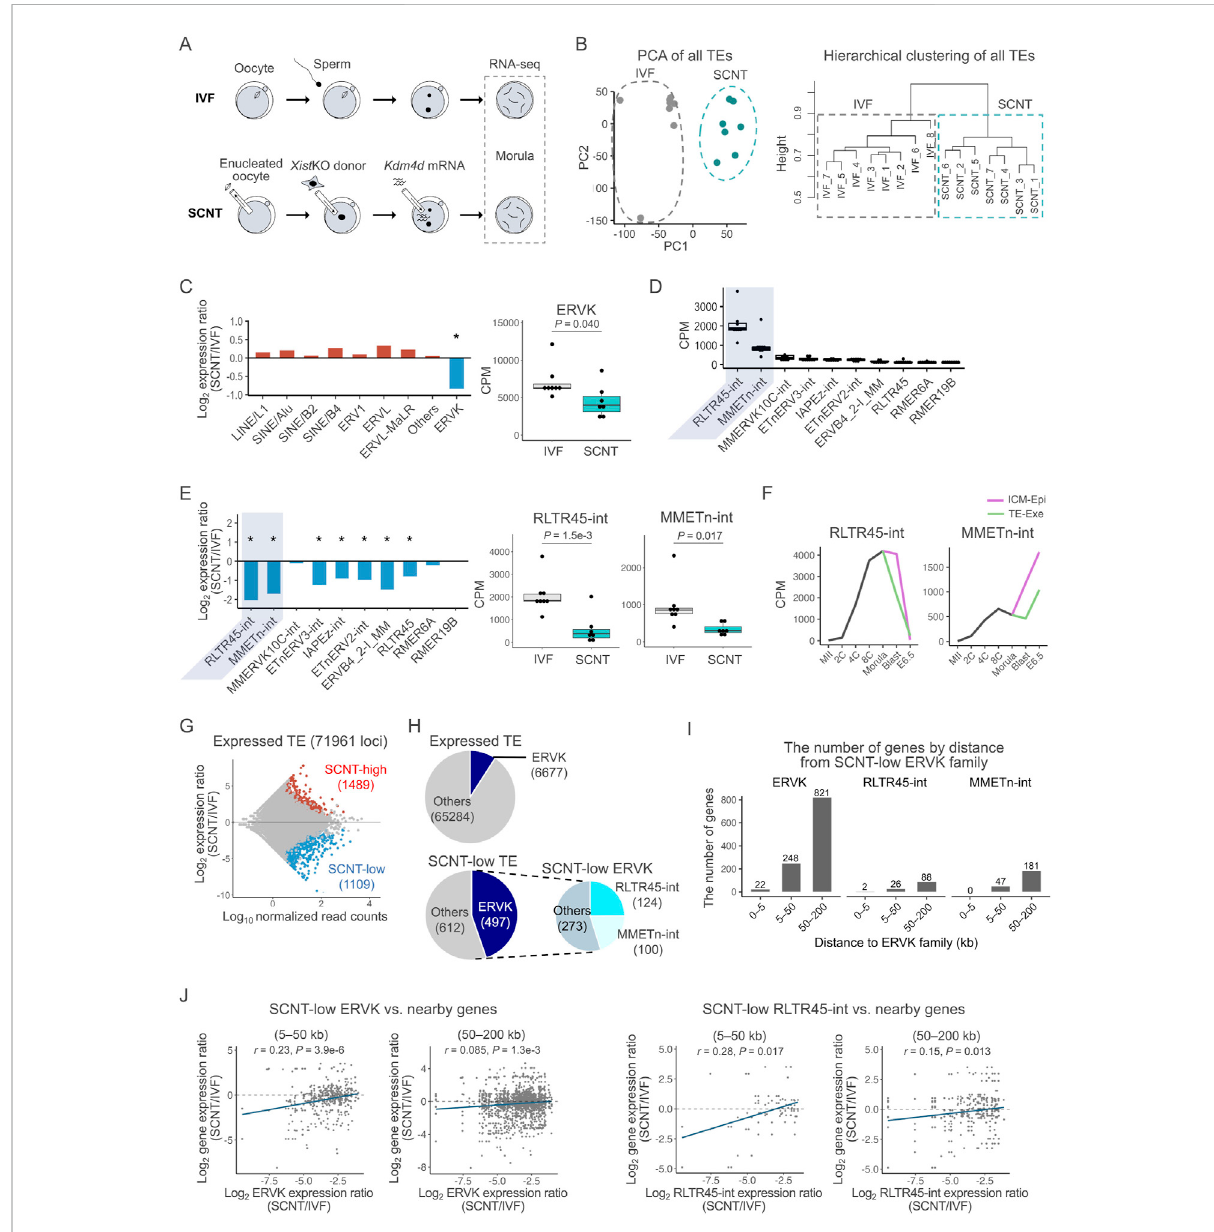
FIGURE 1 Expression of ERVK was suppressed in SCNT-derived embryos. (A) Schematics of the experimental design. Embryos at the morula stage were used for single-embryo RNA-seq analysis (B) PCA of the genome-wide TE expressions in IVF and SCNT-derived embryos. Grey and blue dots representIVF-andSCNT-derivedembryos,respectively(left).Hierarchicalclusteringanalysisofthegenome-wideTEexpressionsinIVF-andSCNT- derived embryos (right). (C) Bar graph showing the log 2 expression ratio of each TE family in IVF and SCNT-derived embryos (left). Box-and- whisker plots comparing the expression of ERVK between IVF- and SCNT-derived embryos. P was calculated by atwo-tailed t -test (right). * p < 0.05. (D) Box-and-whisker plots showing the expressions of the top 10 most highly expressed ERVK subfamilies. RLTR45-int and MMETn-int are highlightedingray (E) Bargraphshowingthelog 2 expression ratioofeachERVK subfamilyinIVFand SCNT-derived embryos(left).Box-and-whisker plots comparing the expression of RLTR45-int and MMETn-int between IVF- and SCNT-derived embryos. p values were calculated by a two-tailed t -test (right). * p < 0.05. (F) Line graph showing the average expression levels of RLTR45-int and MMETn-int throughout early embryonic development.PublishedRNA-seqdata(GSE98150)wereanalyzed.ThesamplesusedintheanalysisareMIIoocytes(MII),2-cell-(2C),4-cell-(4C),8- cell- (8C), and morula-stage embryos, inner cell mass (ICM) and trophectoderm (TE) of blastocysts, and epiblast (Epi) and extraembryonic ectoderm (Exe) of E6.5 embryos. (G) MA plot showing the TE expression ratio between SCNT- and IVF-derived embryos. Among 71,961 expressed TE loci, 1,489 were signi fi cantly upregulated (red circles) and 1,109 were downregulated (blue circles) in SCNT-derived embryos. Expressed TE loci were de fi ned as those with at least one read on average per embryo. Differentially expressed TE loci were de fi ned as those with absolute log 2 expression ratio ≥ 1 and an adjusted p -value < 0.1 using DESeq2. (H) The upper pie chart shows the number of expressed ERVK loci out of the total expressed TE loci. Thelower piecharts show thenumberof SCNT-low ERVK lociout ofthetotal SCNT-low TEloci. (I) Bargraph showing